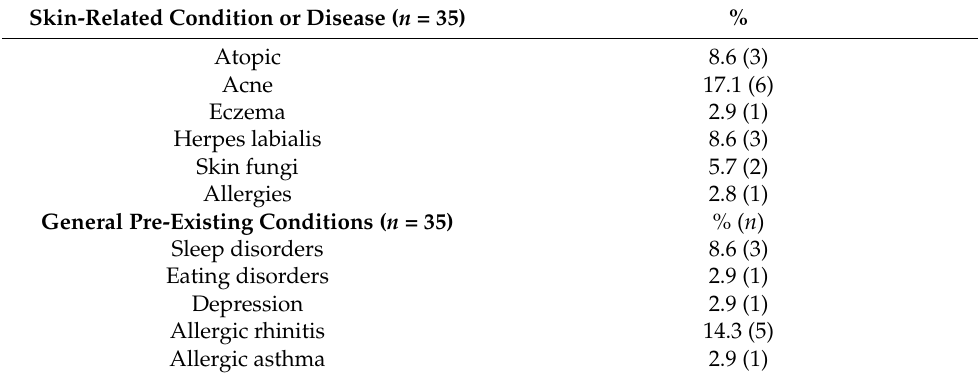
Table 2. Skin-related and other pre-existing conditions of the participants as self-assessment. Skin-Related Condition or Disease ( n =